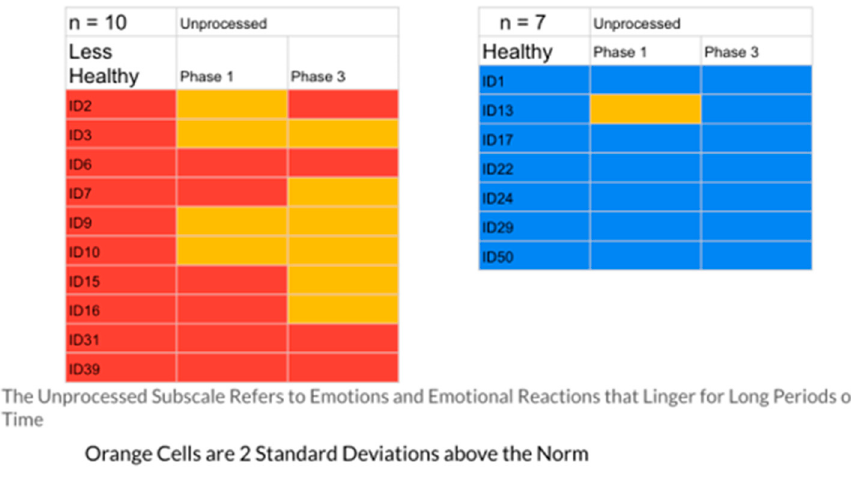
Figure 3. The Controllability Scale EPS: Less Healthy vs. Healthy Coping Groups. Figure 4. The Avoidance Scale EPS: Less Healthy vs. Healthy Coping Groups.